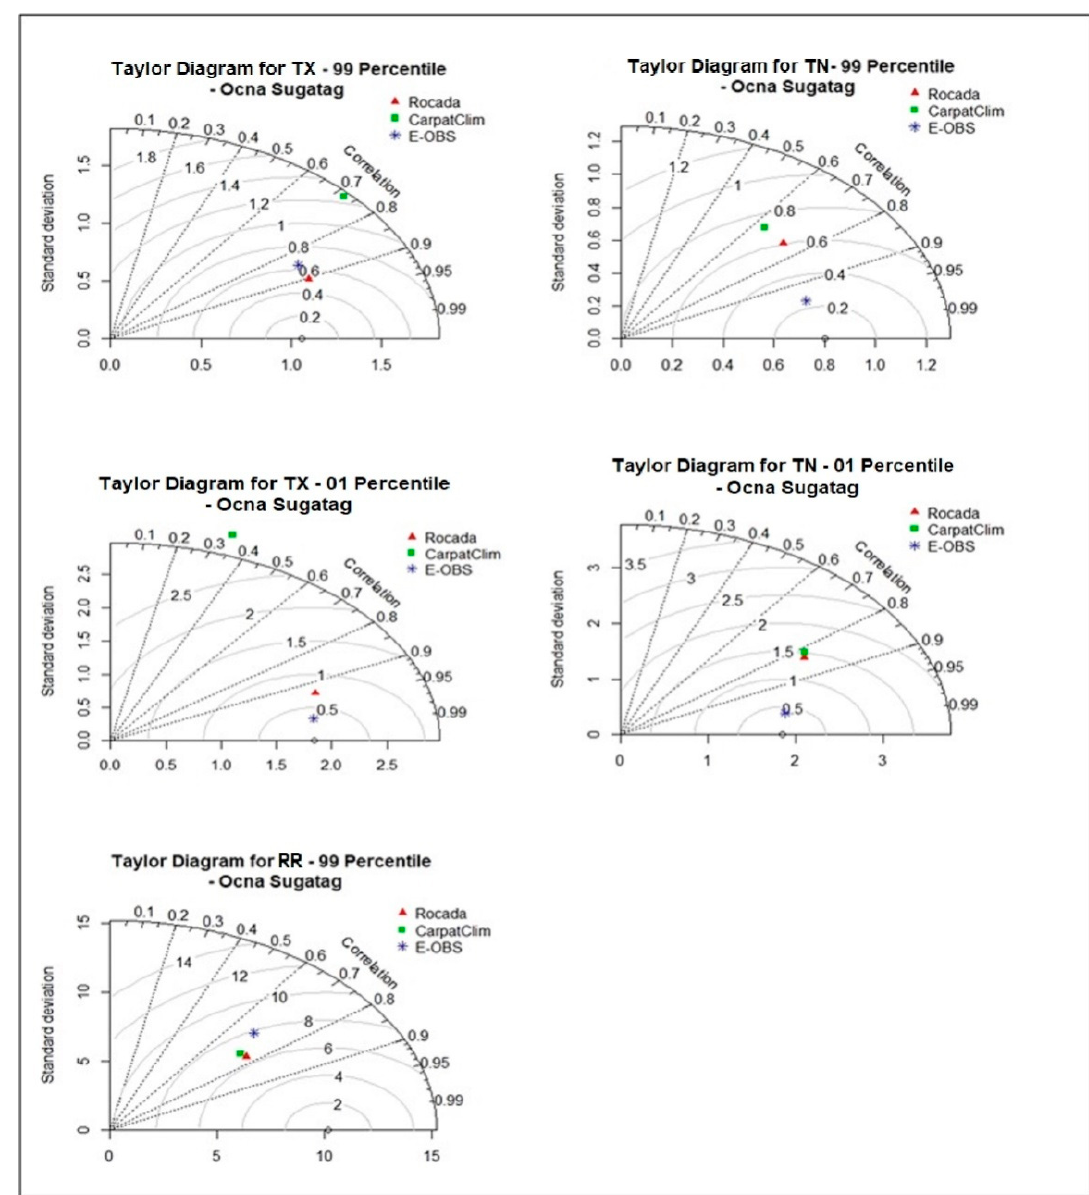
Figure 4. Taylor diagram for the 1st and 99th percentiles, the Ocna Ș ugatag weather station. Using Taylor charts for historical extreme values allowed us to identify the position of gridded data as compared with the reference data. For the 99th percentile (for maximum values), the ROCADA database is generally in a better (closer) position, and for the 1st percentile (for minimum values) the data from E-OBS are more accurate. This was surprising, because to obtain the E-OBS gridded dataset, a lower density of weather stations was used than in the case of the ROCADA and CARPATCLIM databases. It was expected that the ROCADA database, which was developed based on the highest density of weather stations, would better capture the extreme values.